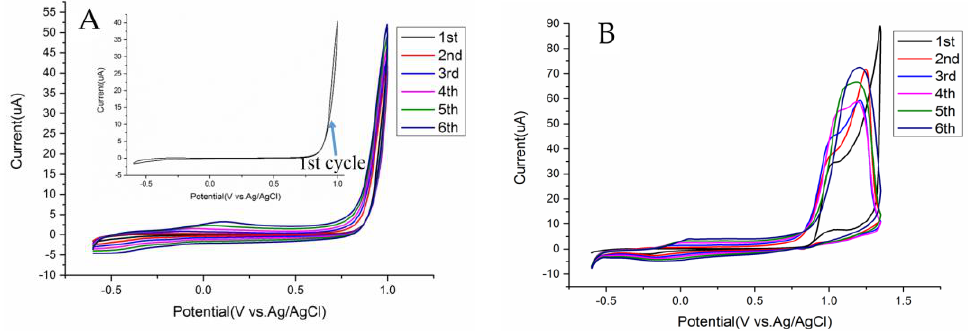
Figure 3. Six-repetitive cyclic voltammograms of 10.0 mM EDOT in aqueous solution containing the mixture of 0.1 M LiClO 4 and 5 mM C 12 H 25 SO 4 Na in different potential range: −0.6 V–1.0 V ( A ); −0.6 V–1.35 V ( B ) Scan rate; 50 mV/s.